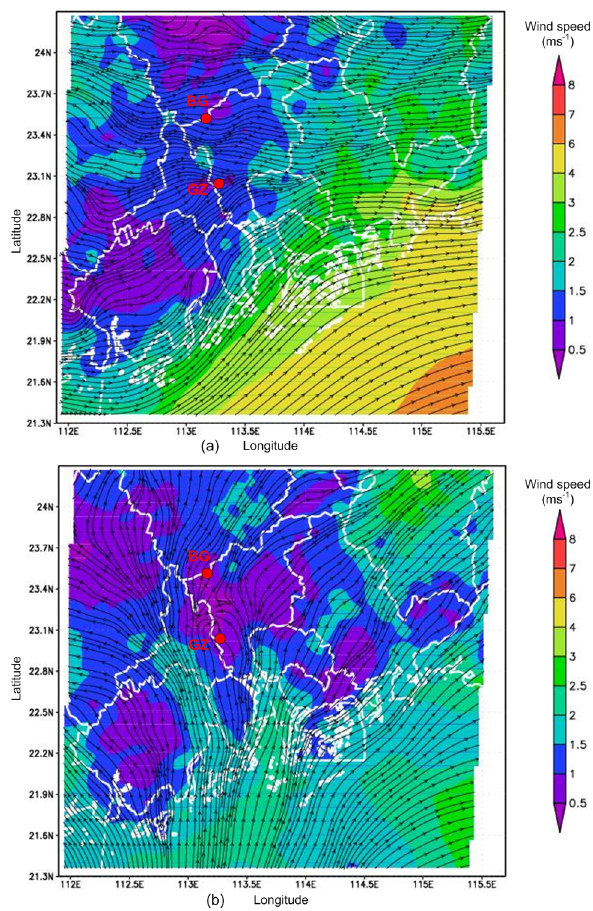
Fig. 6. Wind fields in the PRD region in the late afternoon of 12 and 19 July. The arrows show the